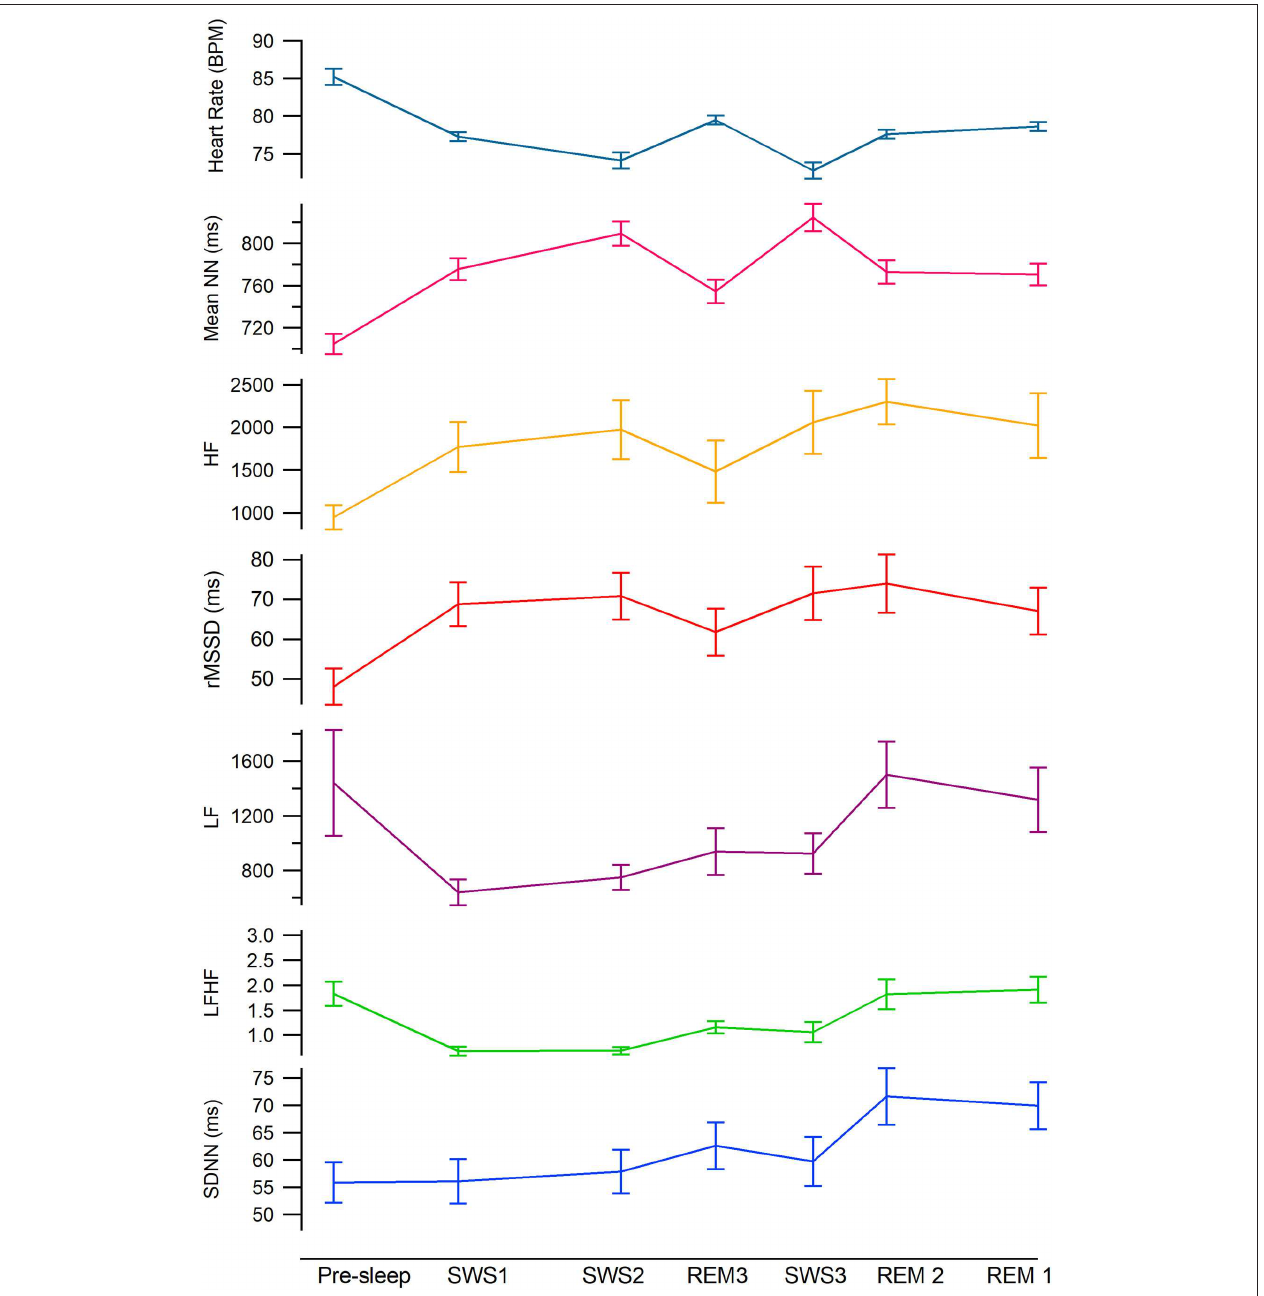
FIGURE 2 | Mean heart rate variability values across the night by sleep stage. From the top teal: heart rate, hot pink: meanNN, gold: HF, red: rMSSD, magenta: LF, green: LF:HF, blue: SDNN. Mean time of each epoch are as follows; Sleep onset, 2140 SWS1, 2258, SWS2, 2444, REM3, 0139, SWS3, 0240, REM2, 0326, REM1, 0501 (see Table 1 for time standard